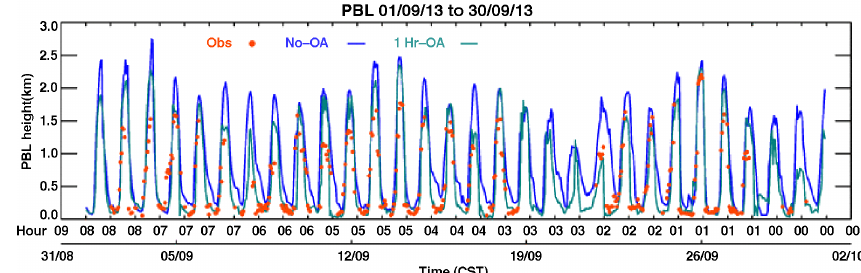
Figure 6. Planetary boundary layer (PBL) height time series at CAMS C695 for September